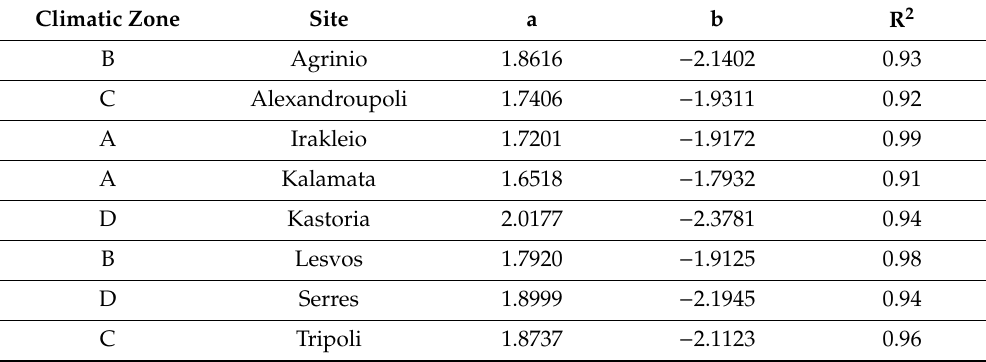
Table 4. Coefficients and R 2 of the relationship k ’ d = a + b k ’ t for the eight selected sites in Greece. The relationships have been derived from monthly mean k ’ d , k ’ t values under all-sky conditions during TATY.